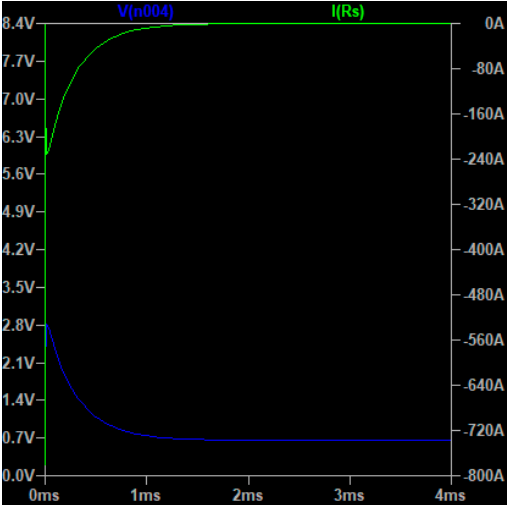
Figure 10. Time simulation for the discharge of C 2 across the DUT without additional resistance. Current flow (green line), voltage of C 2 (blue line) over time.